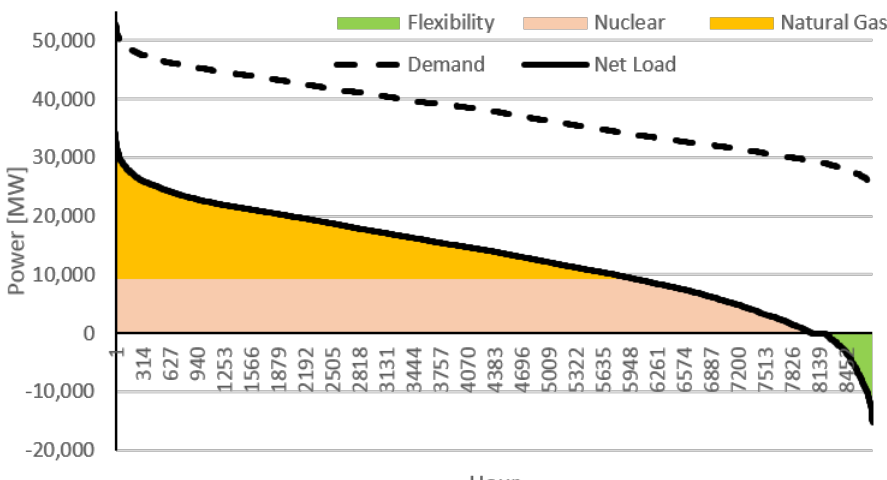
Figure 6. Iberian nRESL monotone curve and cooperative technology power division in 2030.